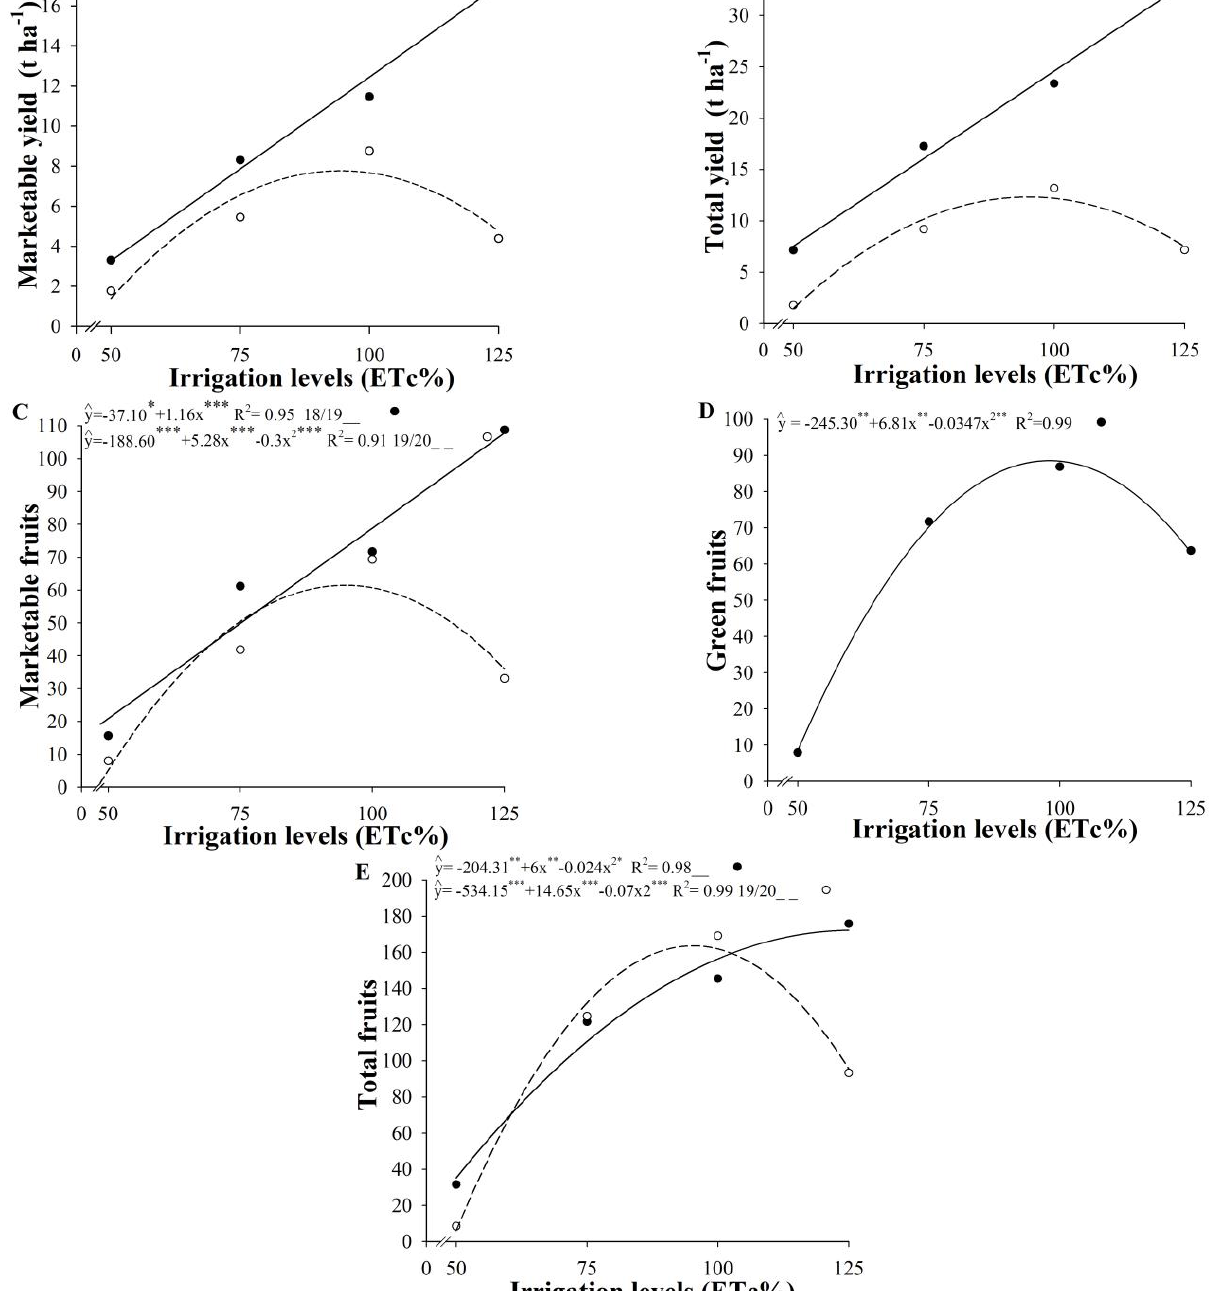
Figure 3. Marketable yield ( A ) and total yield ( B ) — ton ha −1 , and number of marketable fruits ( C ), green fruits ( D ), and total fruits ( E ) of fig plants grown under semiarid climatic conditions in the 2018/2019 and 2019/2020 crop years. * Significant ( p < 0.05); ** ( p < 0.01); *** ( p < 0.001). The first crop year (18/19) linearly influenced the MF, resulting, with the water defi- cit, in the lowest values. In the second year (19/20), for the same variable, the highest mean (61.60 fruits) was obtained at the Li of 94.89% ETc (Figure 3C). On the other hand, there was a greater number of green fruits (GF) (91.50 fruits) at the Li of 98.42% ETc (Figure 3D). For the TF, in the first and second years (18/19), the highest total numbers of fruits (169.69 and 162.69 fruits) were obtained at the Li of 125% and 95.13% ETc, respectively (Figure 3E). The irrigation levels influenced the water-use efficiency (WUE) and the irrigation water-use efficiency (IWUE) in the two crop years ( p < 0.05). In the first year (18/19), the